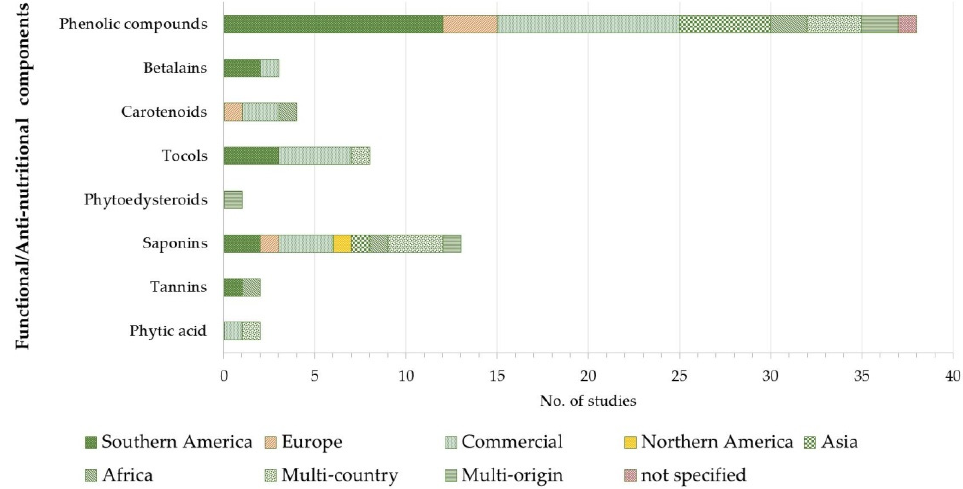
Figure 2. Distribution of included studies by functional/anti-nutritional component class and sample geographical origin.